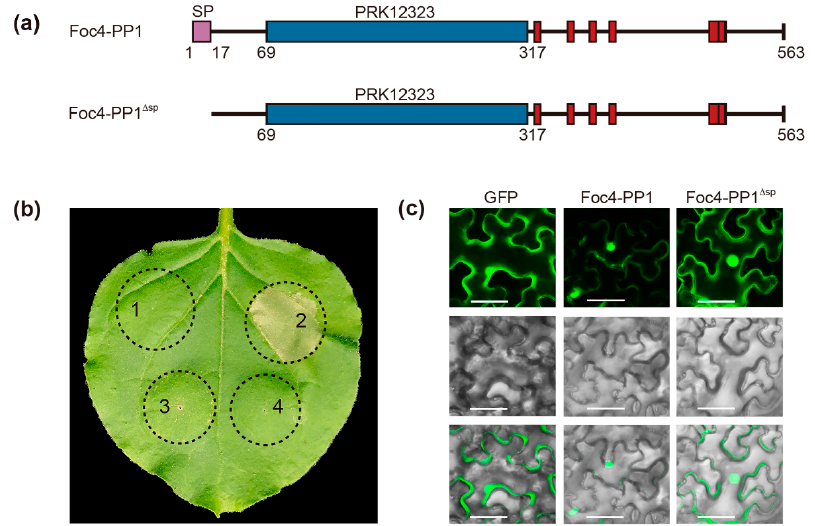
Figure 4. Foc4-PP1 suppresses BAX-induced cell death in N. benthamiana . ( a ) Schematic illustration of Foc4-PP1 without signal-peptide mutants used in this study. ( b ) Suppression of BAX-triggered cell death in N. benthamiana by Foc4-PP1. In fi ltration with Agrobacterium strain GV3101 carrying pCambia 1305:Foc4-PP1, pCambia 1305:BAX, pCambia 1305:Foc4-PP1 ∆ sp , and pCambia 1305:GFP. 1: